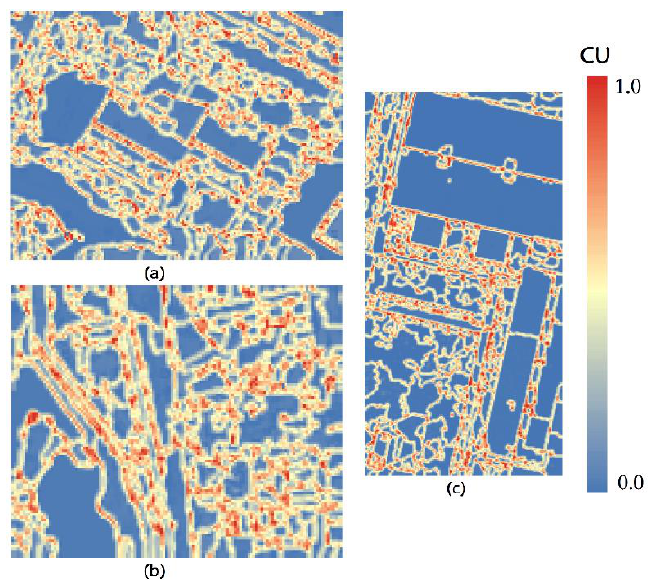
Figure 8. Calculation results of image uncertainty: ( a ) Vaihingen image, ( b ) Beijing2 image, and ( c ) Potsdam image.